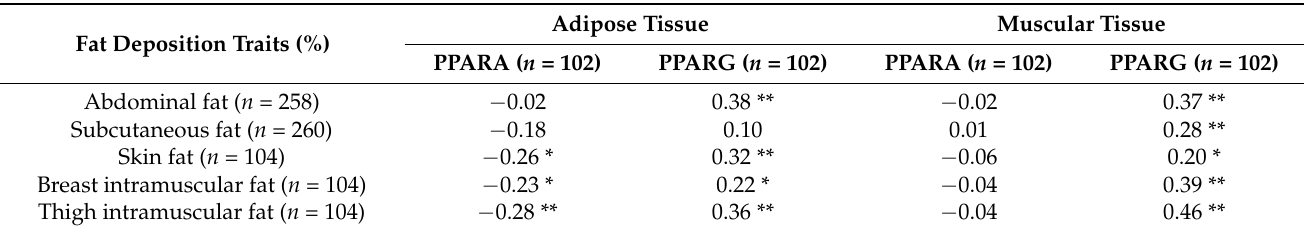
Table 2. Pearson correlation coefficient between PPARs mRNA expression and fat deposition traits in both adipose and muscle